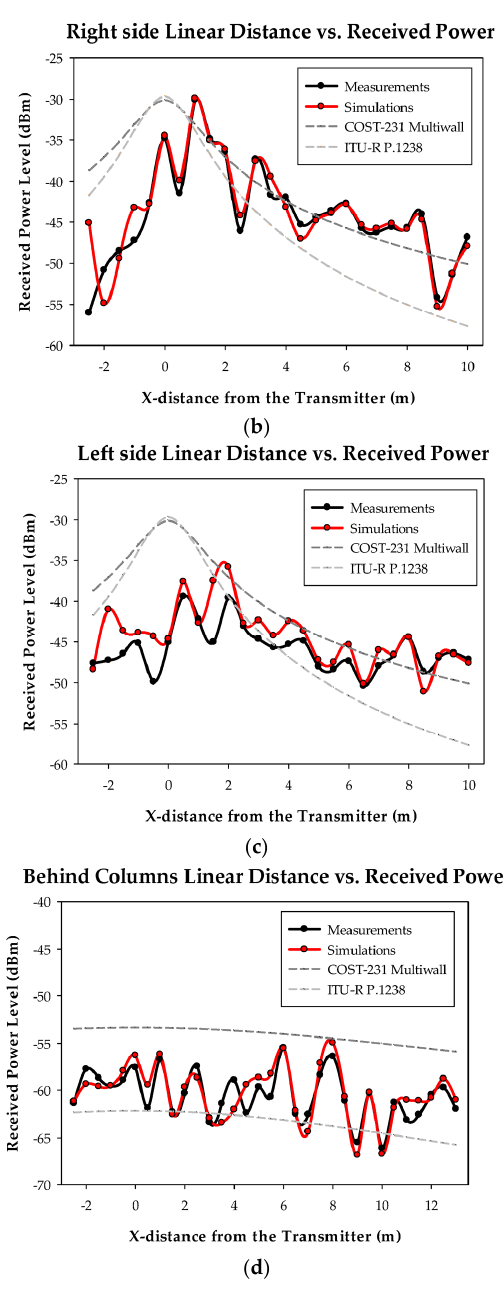
Figure 7. Linear distance vs. received power level corresponding to the dashed lines depicted in Figure 6: ( a ) Center; ( b ) Right side; ( c ) Left side; ( d ) Behind columns.